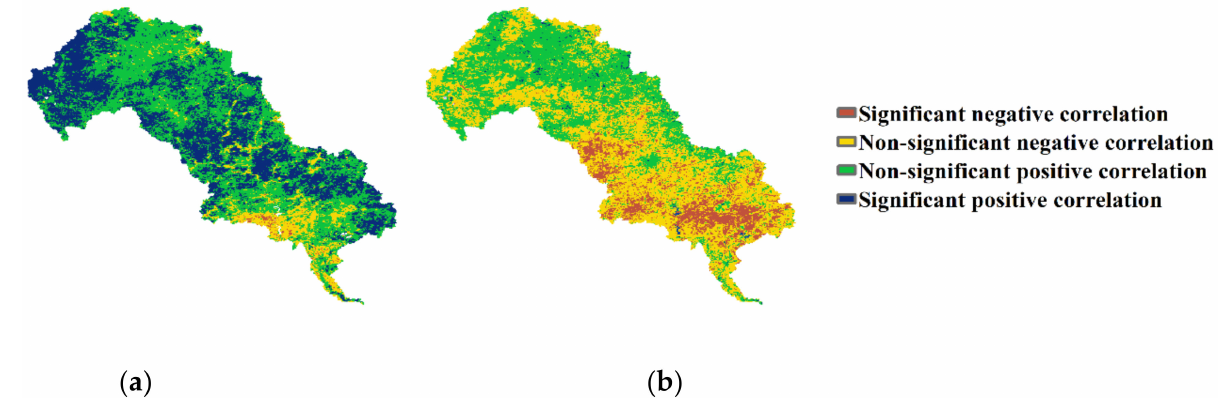
Figure 13. ( a ) Spearman coefficient between MAP and EQ from 2001 to 2020 by pixel, ( b ) Spearman coefficient between MAT and EQ from 2001 to 2020 by pixel (0.05 significance